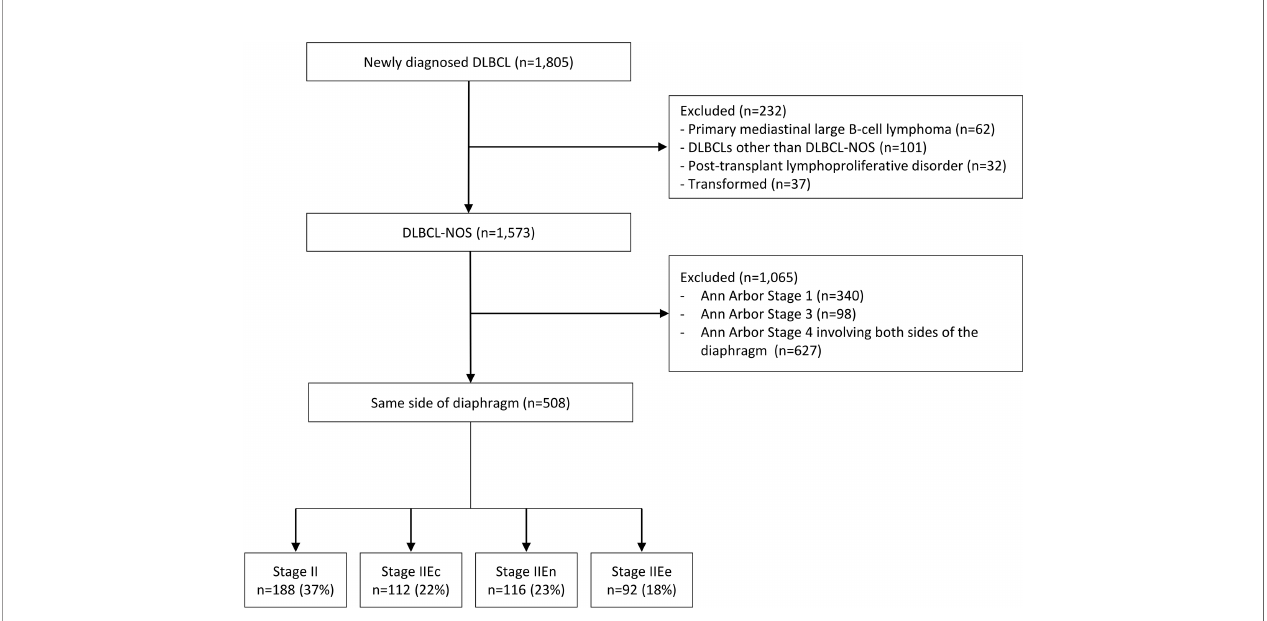
FIGURE 1 | Flow diagram. DLBCL, diffuse large B-cell lymphoma; NOS, not otherwise speci fi ed. The disease stages are de fi ned as follows: 1) II, nodal stage II, 2) IIEc, 1 extranodal involvement with contiguous nodal involvement; 3) IIEn, 1 extranodal involvement with non-contiguous nodal involvement; and 4) IIEe, ≥ 2 extranodal involvement but limited to the same side